Question: Identify the chart type used in this figure.
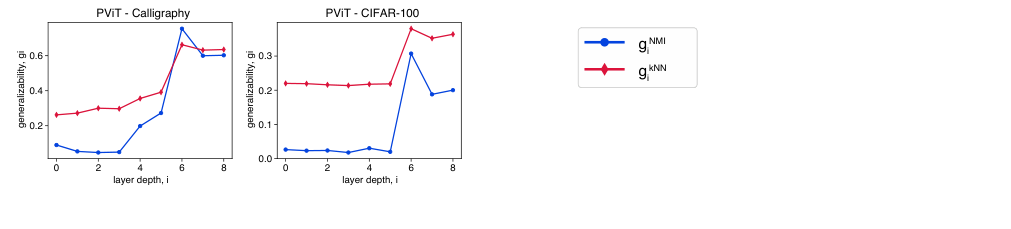
Answer: line